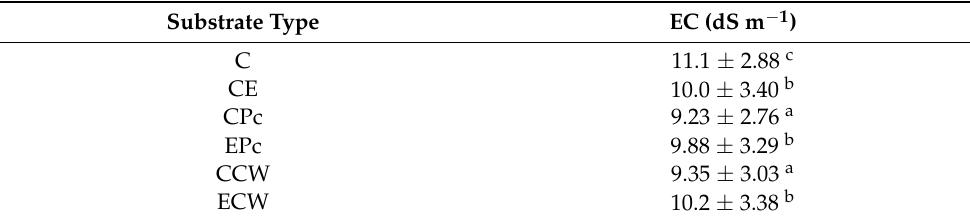
Table 2. Electrical conductivity (EC) of the pot substrates after one month of plant growth. Soil sampled in the Chinampas area was used as control (C); soil contaminated with endosulfan (CE); soil bioremediated with Penicillium crustosum (CPc); endosulfan-contaminated soil, bioremediated with P. crustosum (EPc); soil bioremediated with citric waste (CCW); endosulfan-contaminated soil, bioremediated with citric waste (ECW). Values represent the means of five samples per treatment, followed by SD. Different letters indicate significant differences between treatments, according to the Tukey test, at the 99% confidence level.